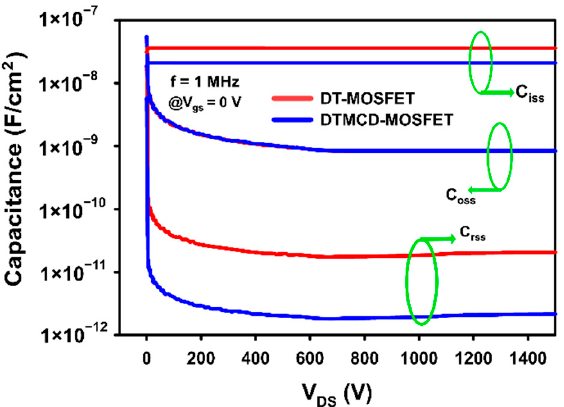
Figure 11. Parasitic gate-drain capacitance, input and output capacitance curves of DT-MOSFET and DTMCD-MOSFET with V GS = 0 V.